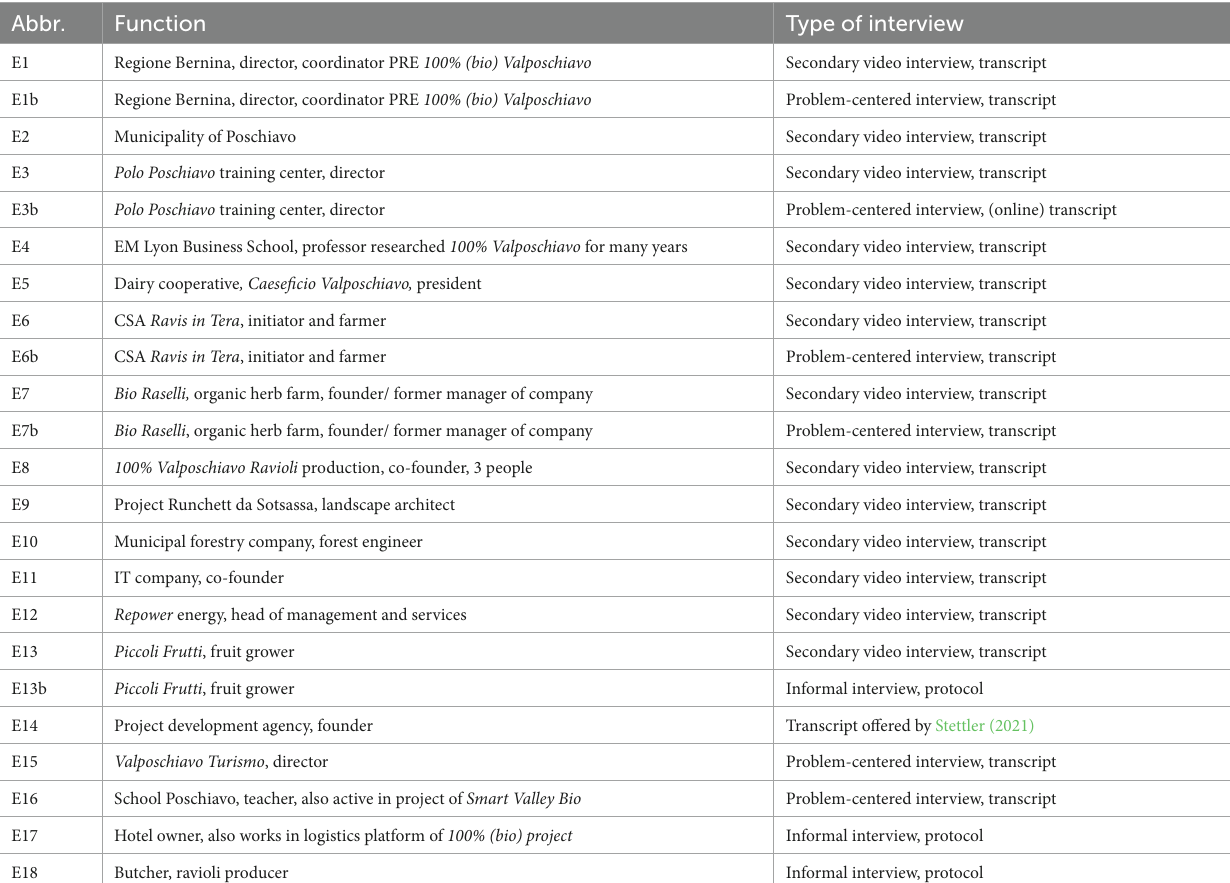
TABLE 1 Interview participants, listed with their functions and the type of interview.